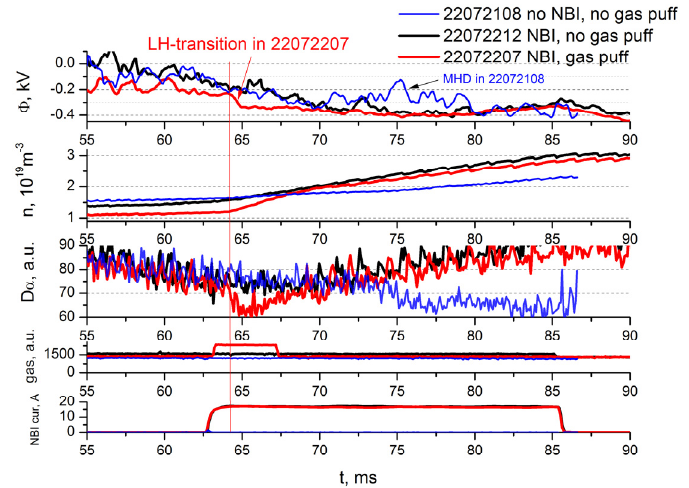
Figure 6. From top to bottom: Plasma potential evolution measured with HIBP in three shots with or without co-NBI (see legend), electron number density evolution, D α emission, gas puffing, and co-NBI beam current. In shots 22072212 and 22072207, co-NBI with energy 21.5 keV and beam current 17 A were applied.